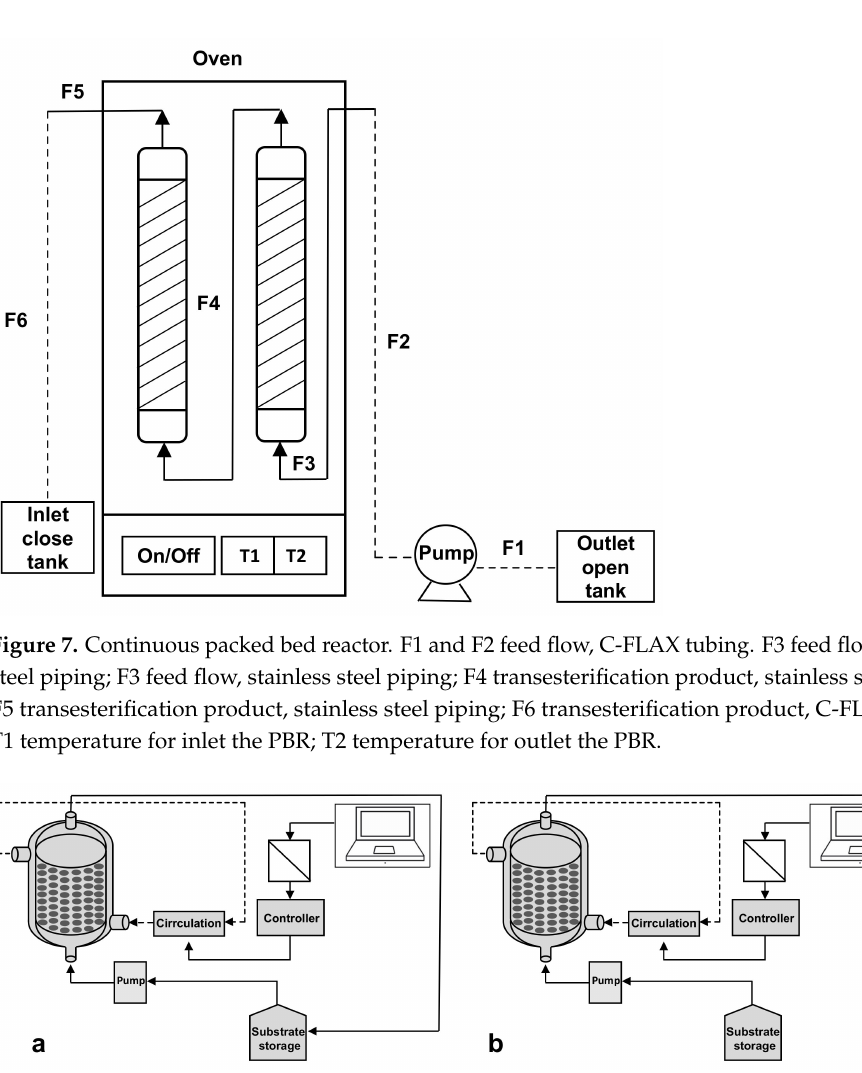
Figure 8. Continuous process with immobilized ( a ) and co-immobilized lipases ( b